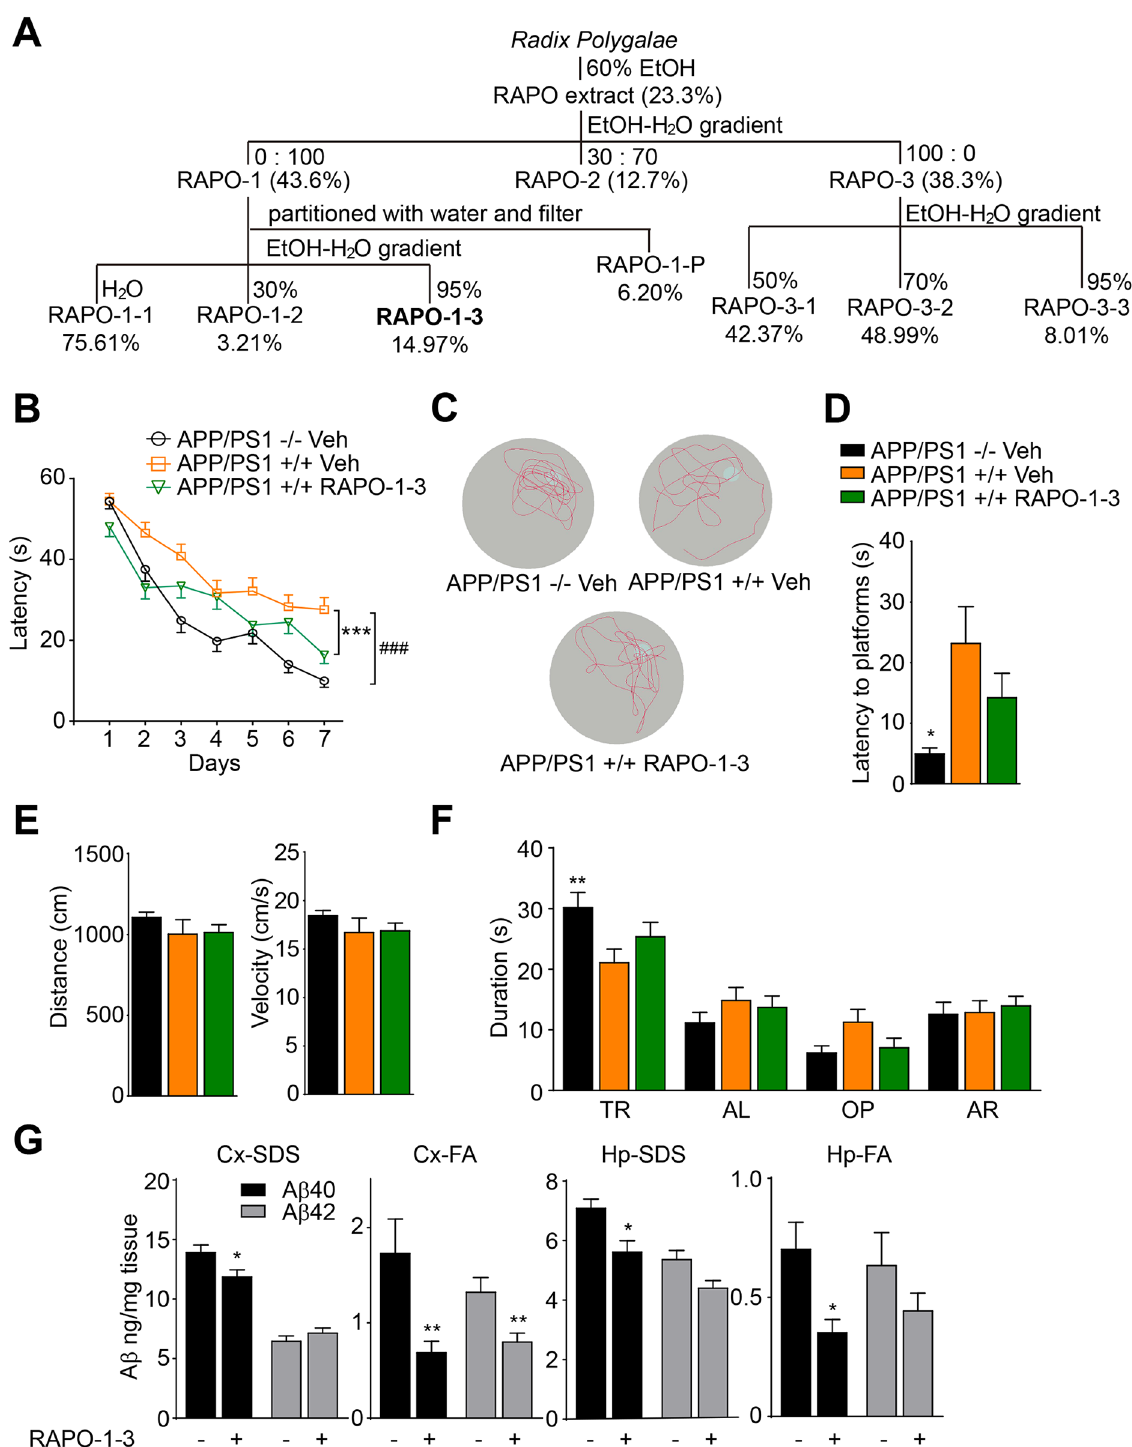
Fig 1. Systemic fractionation identifies RAPO-1-3 as the active fraction of RAPO that reduces A β production. (A) The extraction and fractionation scheme of RAPO. (B) RAPO-1-3 significantly reverses the spatial memory deficit of AD mice. (C) Representative tracks of each group of mice in probe trial test at day 8. (D) The latency to platform in probe trial for each group of mice at day 8. (E) No differences in the swimming distance and velocity among the groups. (F) The time spent by mice in the target quadrant. (G) SDS-soluble and FA-soluble A β 40 and A β 42 levels in the mouse hippocampi and cortices were measured by sandwich ELISA and normalized to control. Data are presented as the mean ± s.e.m. * p < 0.05, ** p < 0.01 and *** p < 0.001. Two-way ANOVA with Bonferroni's multiple comparison test (B, F), one-way ANOVA with Bonferroni's multiple comparison test (D, E) and two-tailed t -test